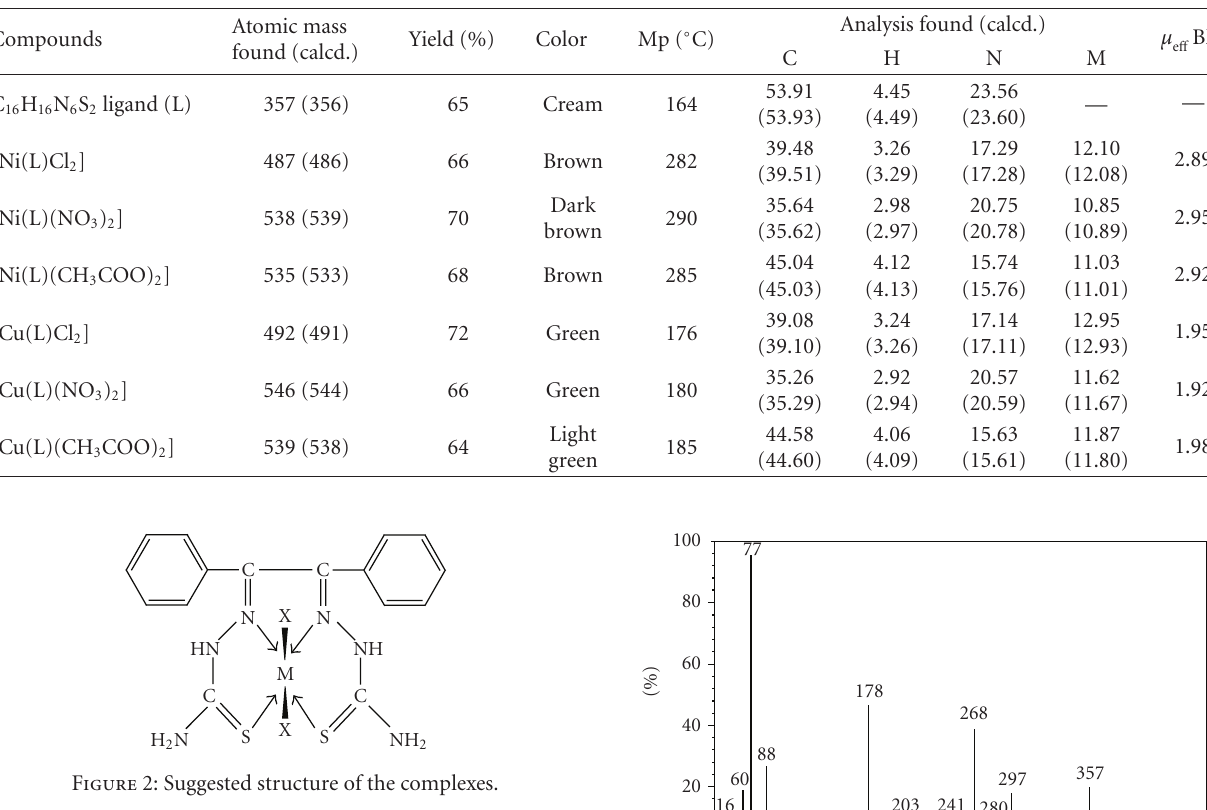
Table 1: Analytical data for the ligand and its Ni(II) and Cu(II) complexes.